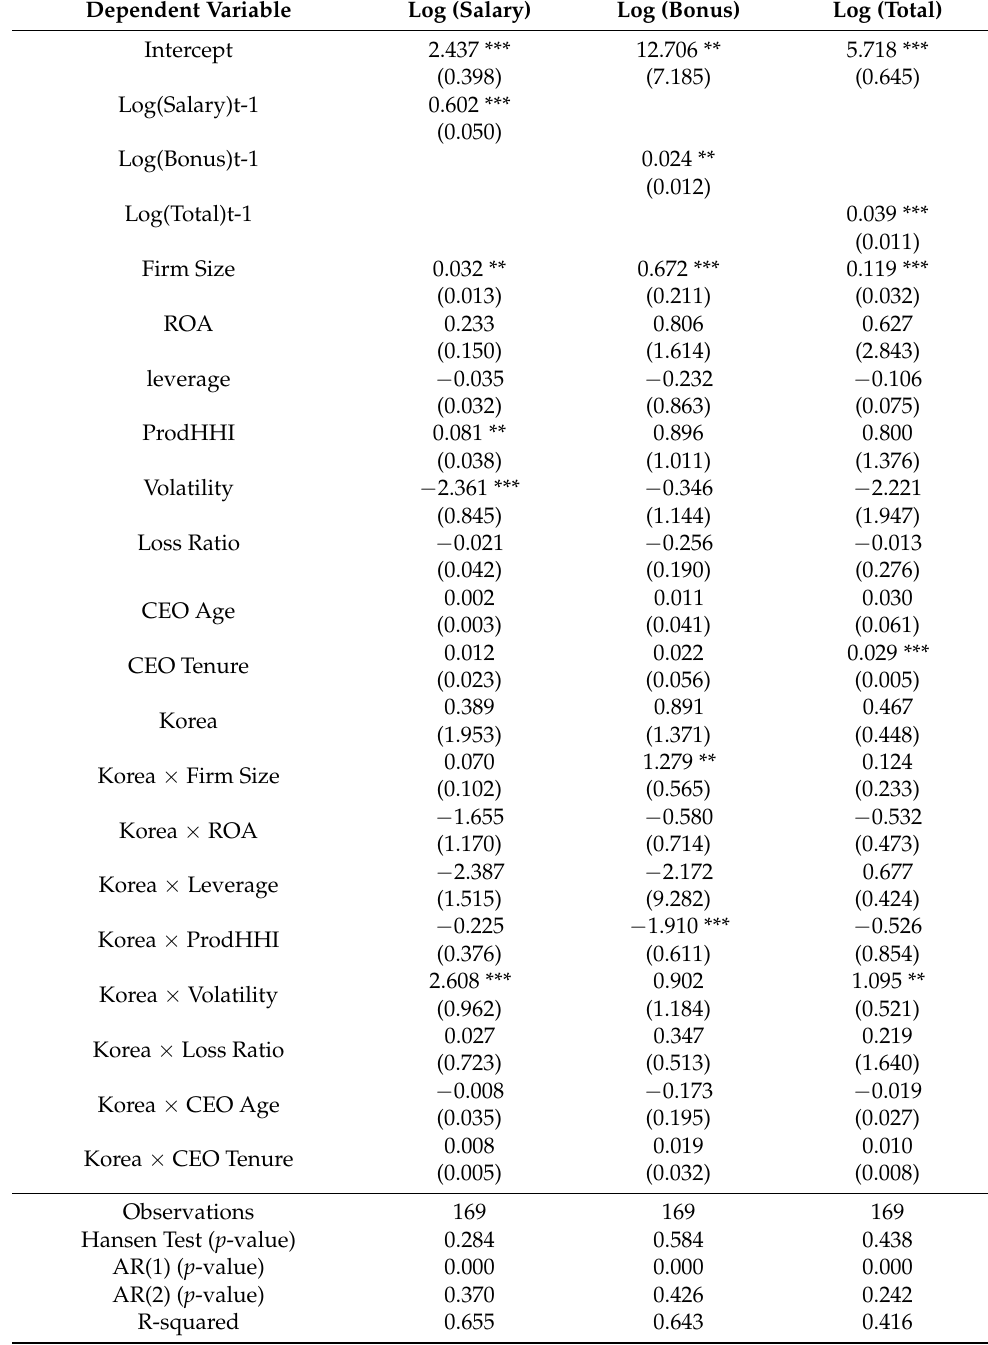
Table 9. Comparison of Determinants of CEO Compensation using system